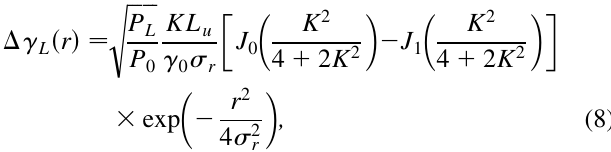
FIG. 7. Slice rms energy spread (cid:27) at 14 GeV for 1% initial density modulation at different wave- lengths (SC wiggler on, no laser